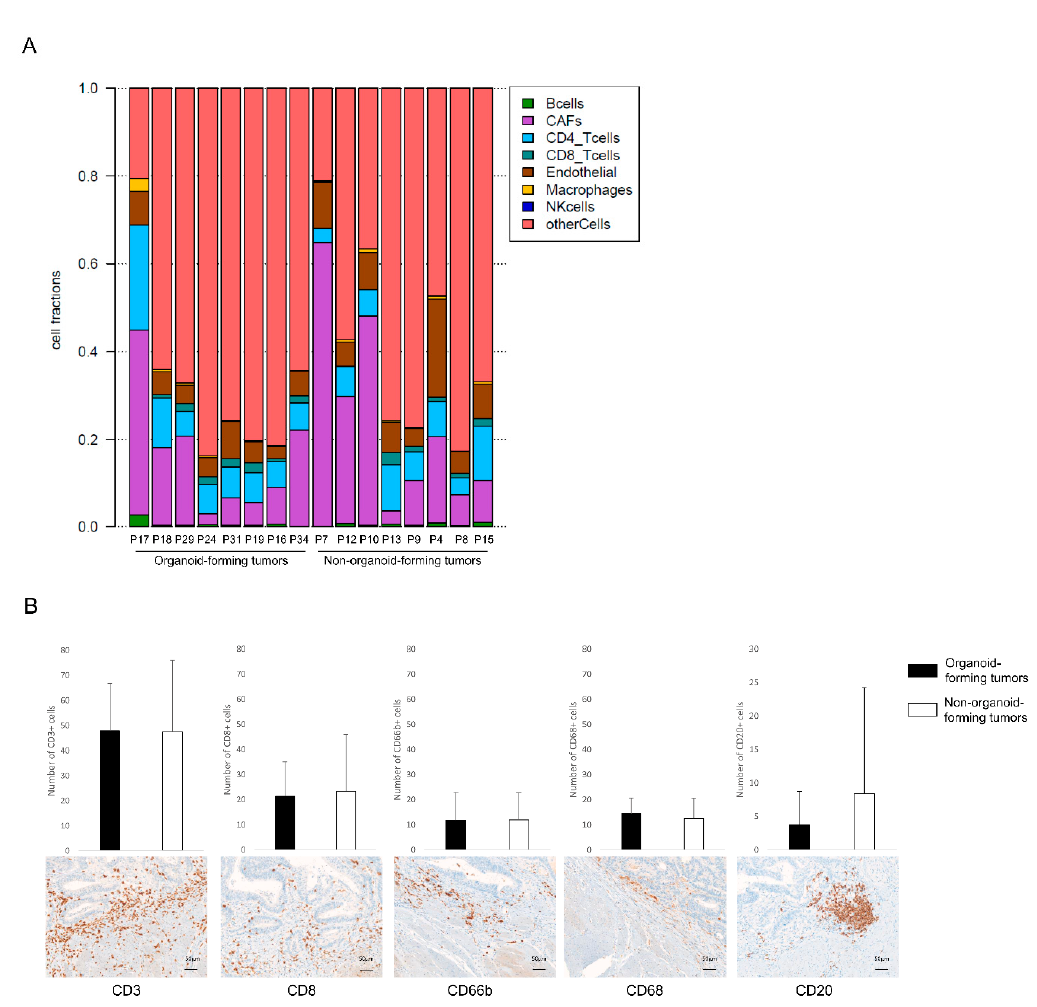
Figure 4. Identification of different immune cell subpopulations in the colorectal cancer (CRC) tumor microenvironment. Estimate of the Proportion of Immune and Cancer cells (EPIC) from tumor RNA sequencing data ( A ); the number of positively stained immune cells between organoid-forming and non-organoid-forming tumors and examples of positive staining for each marker ( B ).